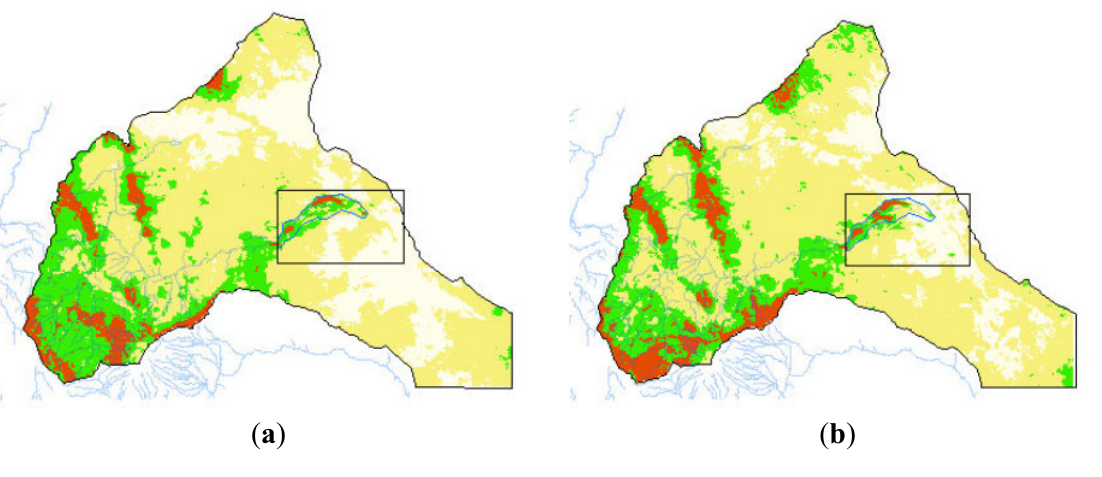
Figure 13. Distribution of NDVI in the Ewaso Ng’iro catchment in ( a ) June 2005; and ( b ) May 2006, showing areas to the southwest of the swamp with high